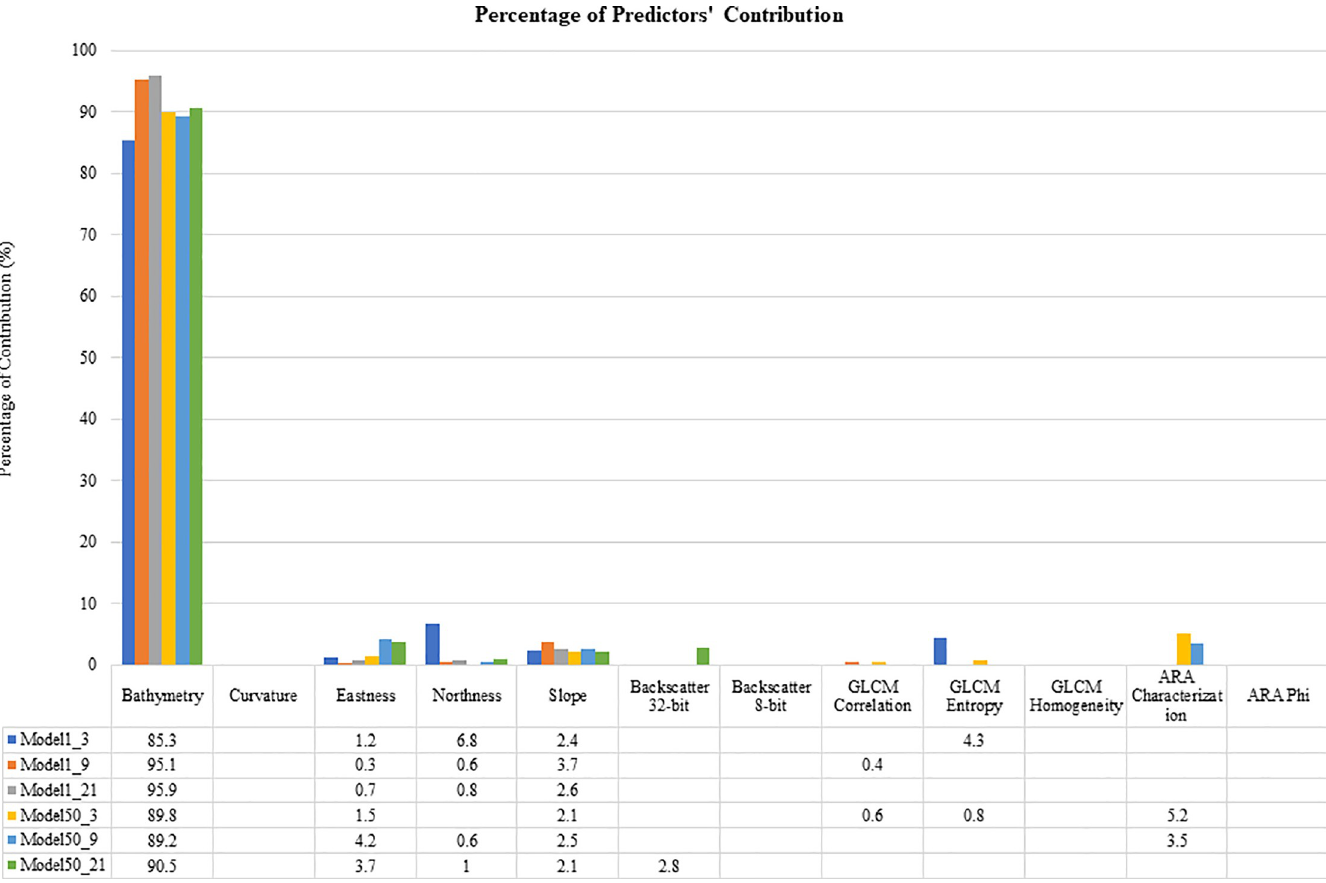
Fig 4. Relative contributions of the bathymetric and backscatter predictors by MaxEnt models. These predictors were used to build the seagrass habitat suitability models.